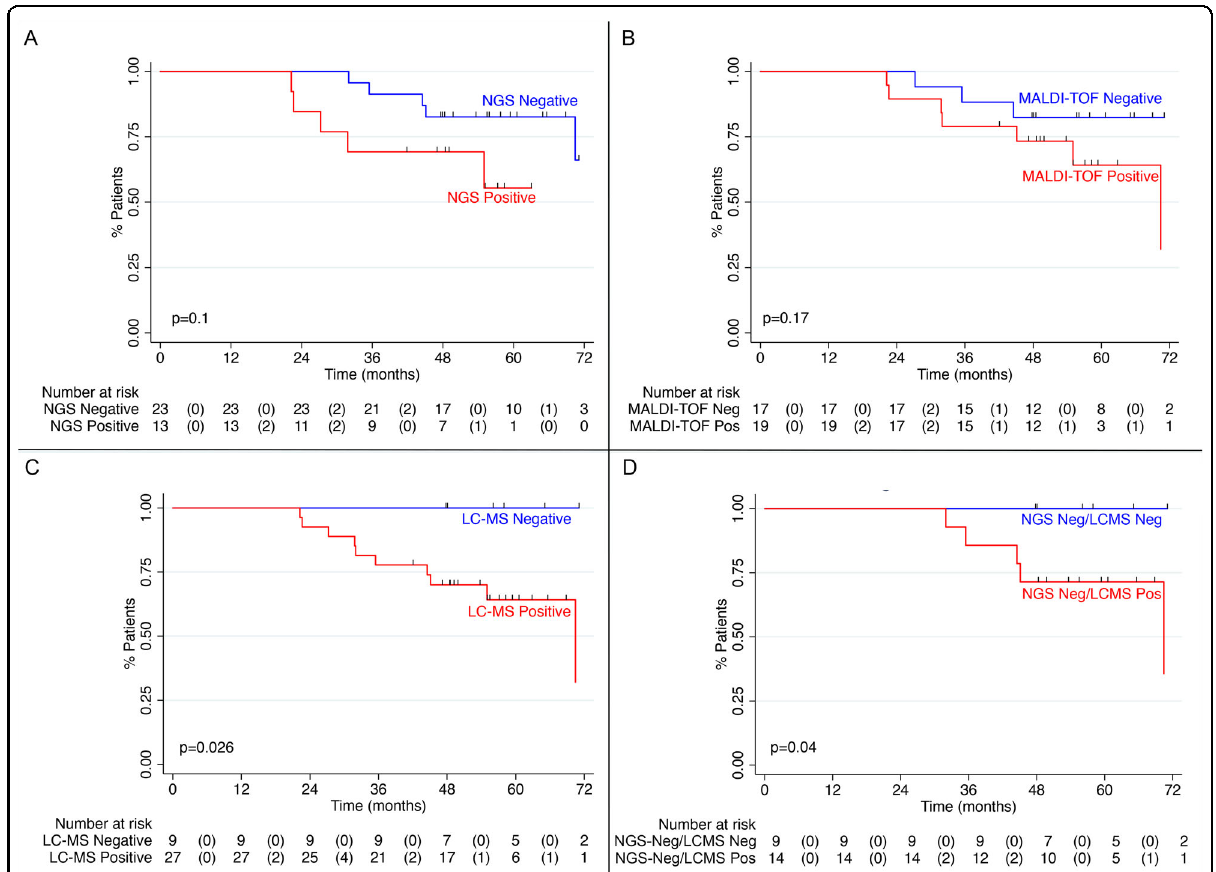
Fig. 2 Progression-free survival by MRD status after 18 cycles KRd. A PFS by NGS status after 18 cycles of KRd; B PFS by MALDI-TOF-MS status after 18 cycles of KRd; C PFS by LC-MS status after 18 cycles; D PFS of all NGS − patients, strati fi ed by LC-MS status. Numbers in parentheses indicate events. KRd car fi lzomib, lenalidomide, dexamethasone, LC-MS liquid chromatography mass spectrometry, MALDI-TOF-MS matrix ‐ assisted laser desorption ionization time ‐ of ‐ fl ight, MRD measurable residual disease, NGS next-generation sequencing; PFS progression-free